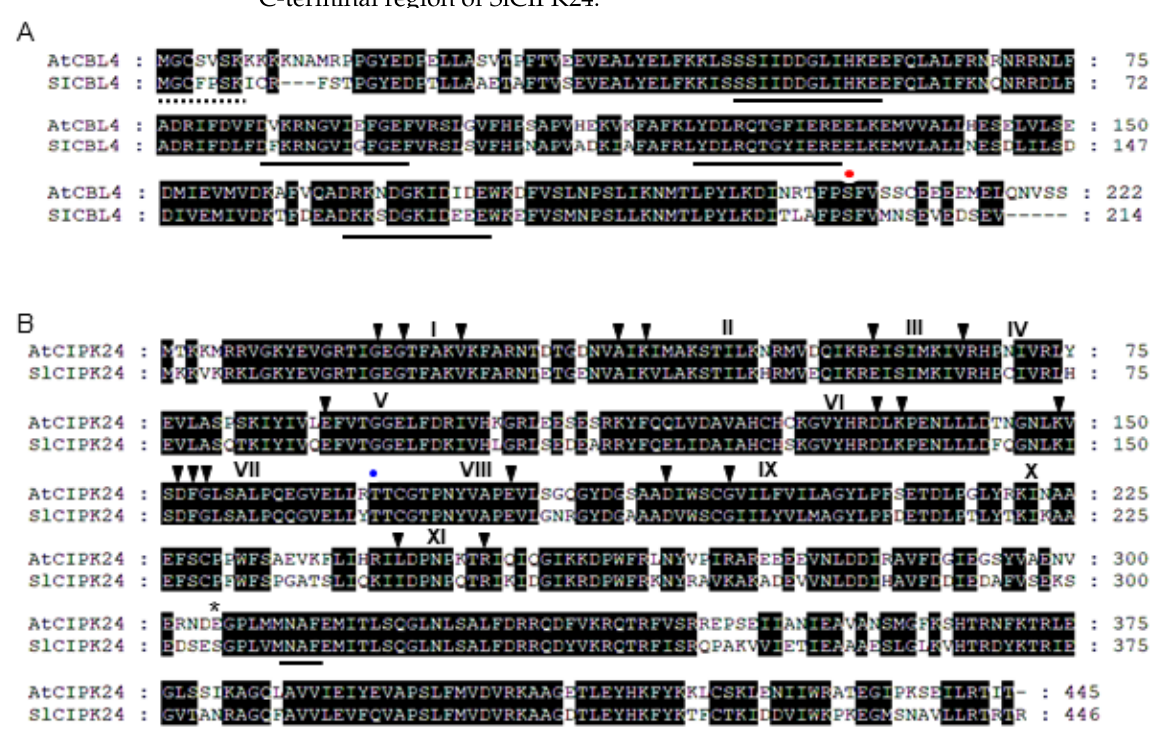
Figure 1. Sequence analysis of SlCBL4 and SlCIPK24. Alignments were performed with the Lasergene MegAlign Program (DNASTAR) and modified with the GeneDoc software. Identical amino acids are shaded black. Dashes represent gaps to maximize the alignment. ( A ) Amino acid sequence alignment of AtCBL4 (AT5G24270) and SlCBL4 (AB675686). The con- sensus N-myristoylation and EF-hand motifs were underlined with dashed and solid lines, respectively. The red dot in- dicates the conserved serine phosphorylation site. ( B ) Amino acid sequence alignment of AtCIPK24 (AT5G35410) and SlCIPK24 (AJ717348). Arrowheads and Roman numerals above the sequences indicate the conserved amino acids and subdomains of serine-threonine protein kinases, respectively. The blue dot and asterisk indicate 168th and 304th amino acid residues, respectively. The NAF motif was